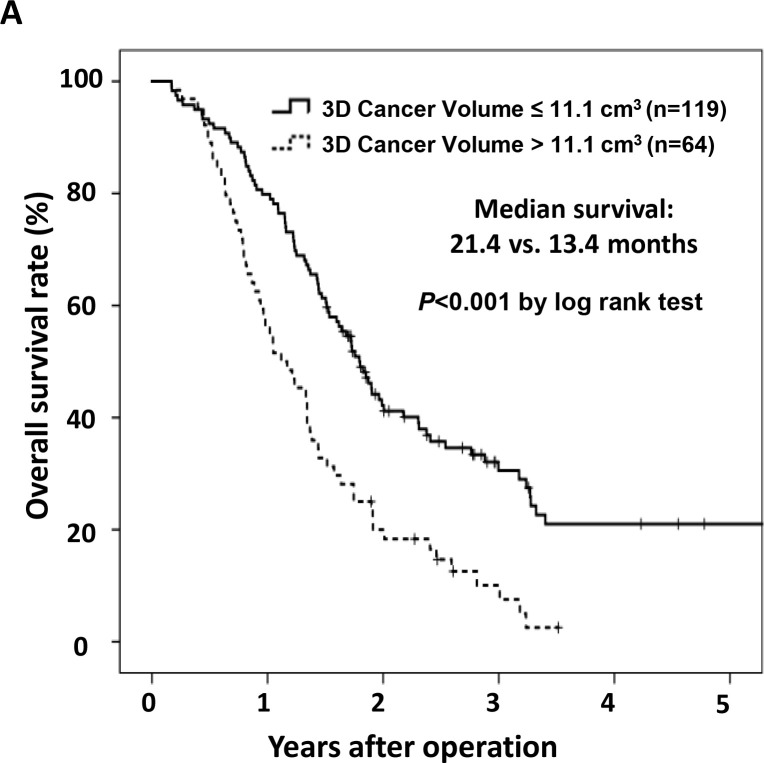
Overall survival curves after surgery according to the tumor volume cut-off level (11.1 cm3).The median survival of the small-volume group (21.4 months) was significantly longer than that of large-volume group (13.4 months, p<0.001).